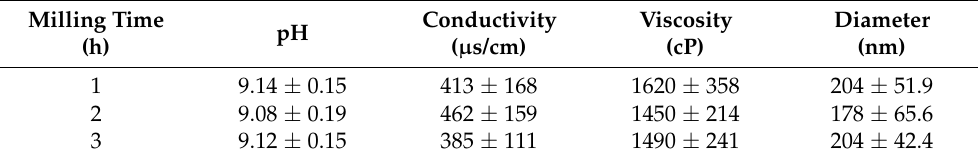
Table 2. pH, viscosity, conductivity, and diameter measured for CB dispersions prepared with SMA-2000 after storing 11 days.